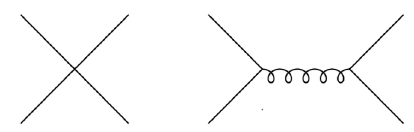
Figure 3. The two types of Feynman diagrams that contribute to the NLSM g four-point amplitude: contact interactions (left) and graviton exchange (right). Note that the straight lines are NLSM scalars and the curly line represents a (intermediate)